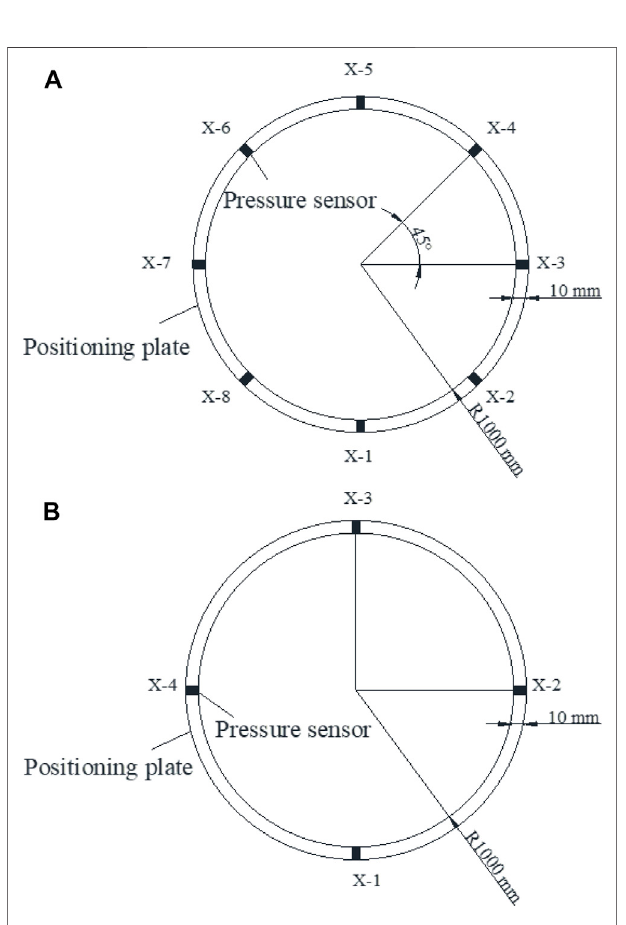
FIGURE 3 | Distribution diagram of pressure sensor on pile (The sensor is named X-Y, where “ X ” represents the positioning part number and “ Y ” represents the sensor number in the positioning part). (A) The layout of eight sensors (B) The layout of four sensors.